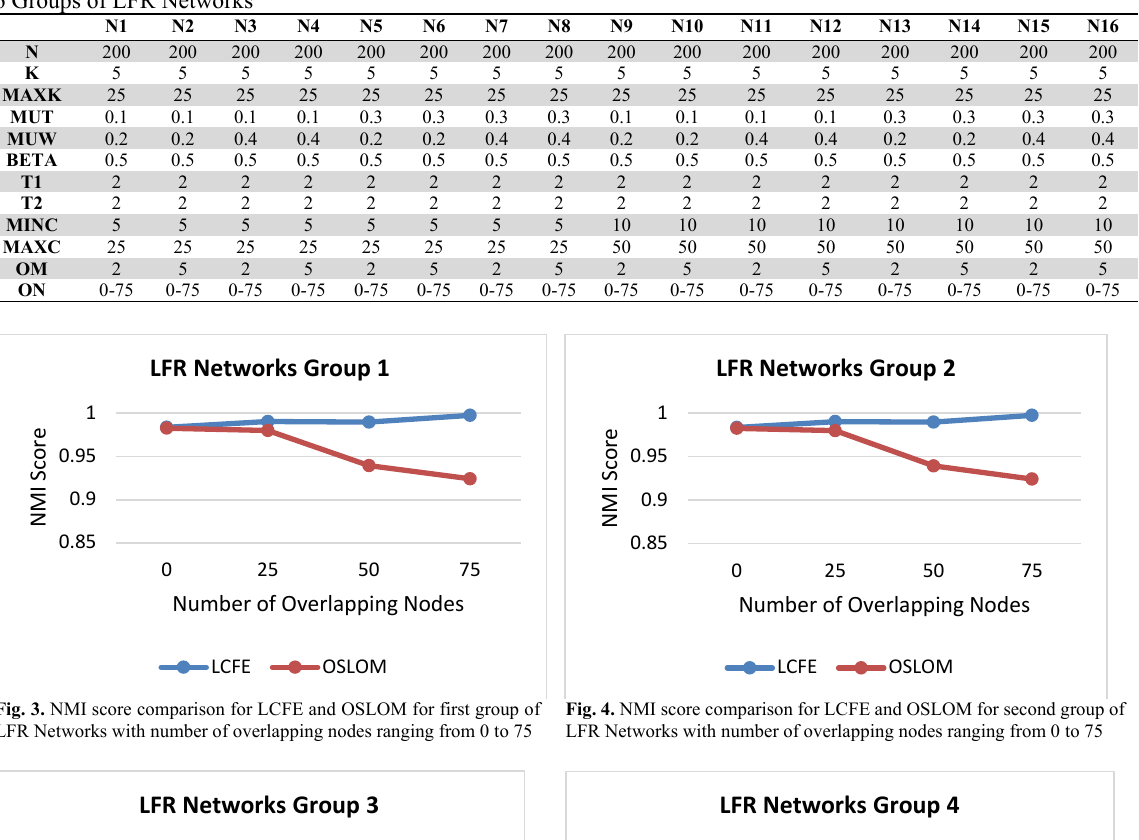
Fig. 6. NMI score comparison for LCFE and OSLOM for fourth group of LFR Networks with number of overlapping nodes ranging from 0 to 75